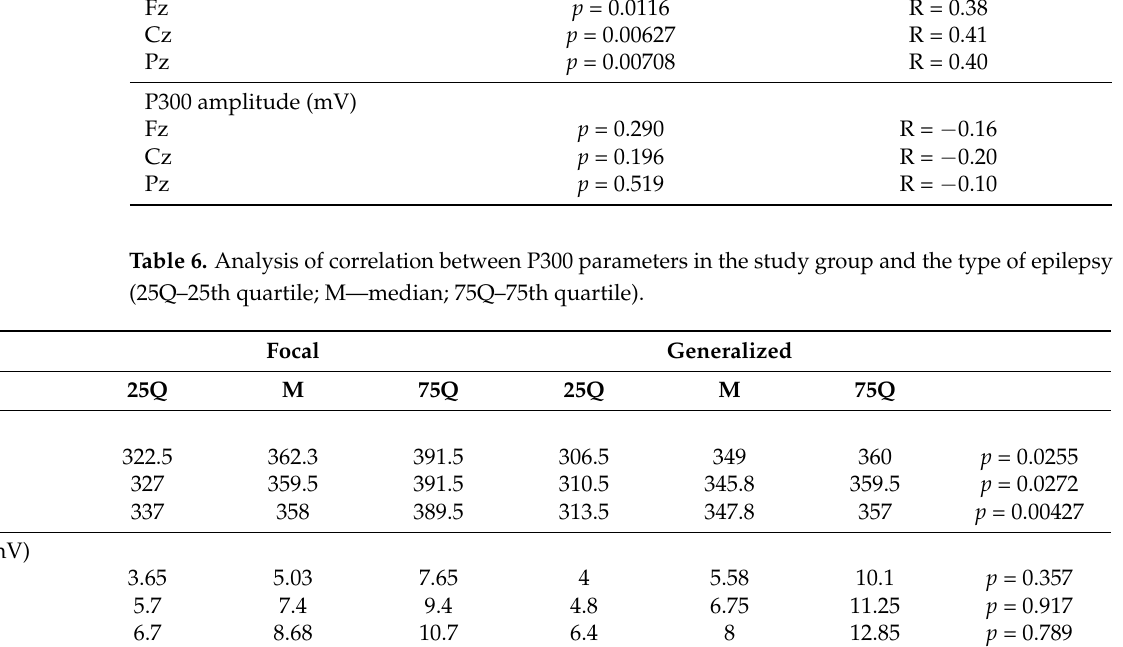
Table 7. Analysis of correlation between P300 parameters in the study group and type of